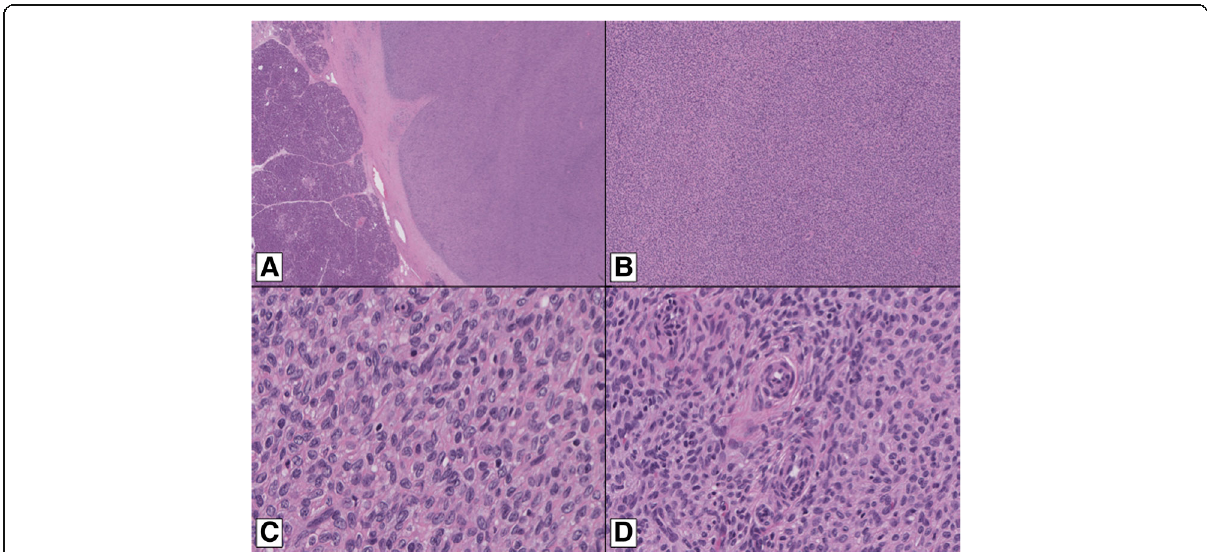
Fig. 2 Histologically, the pancreatic lesion was lobulated, and predominantly well-circumscribed ( a ). It comprised sheets of uniform spindled to epithelioid cells ( b ). The lesional cells had round to oval nuclei, with coarse to vesicular chromatin, visible nucleoli, nuclear grooves and clear to eosinophilic cytoplasm ( c ). Prominent arterioles were seen ( d )